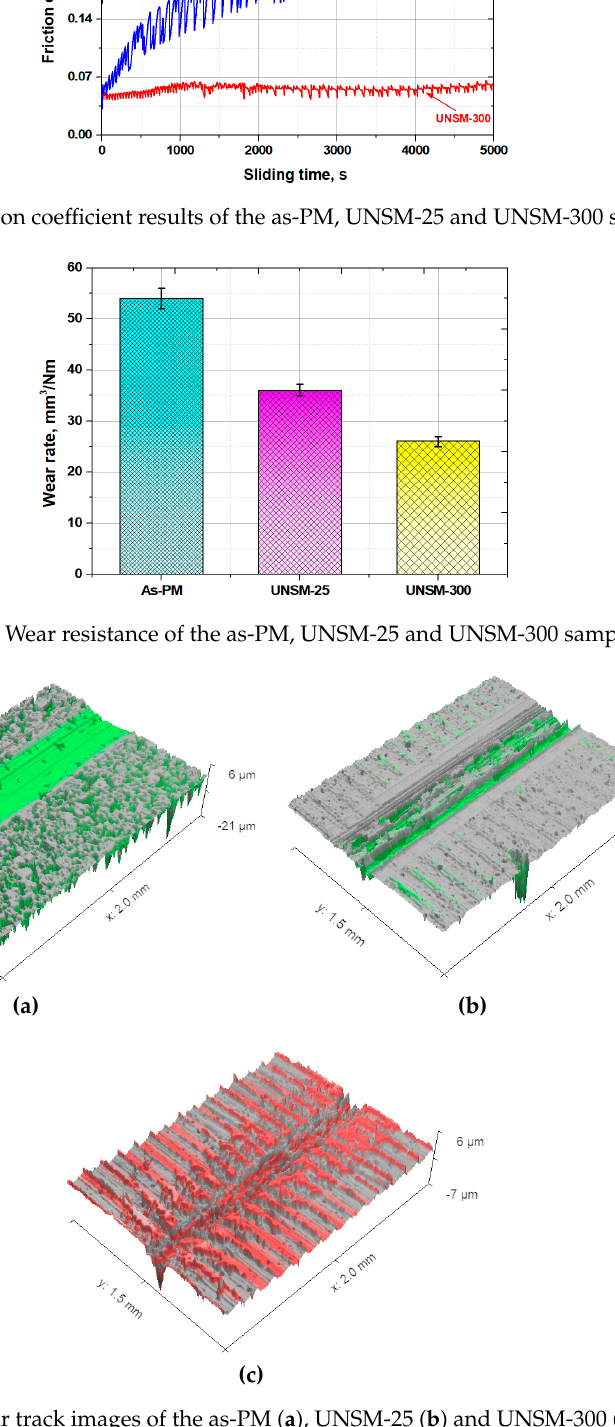
Figure 11. 3D wear track images of the as-PM ( a ), UNSM-25 ( b ) and UNSM-300 ( c ) samples.